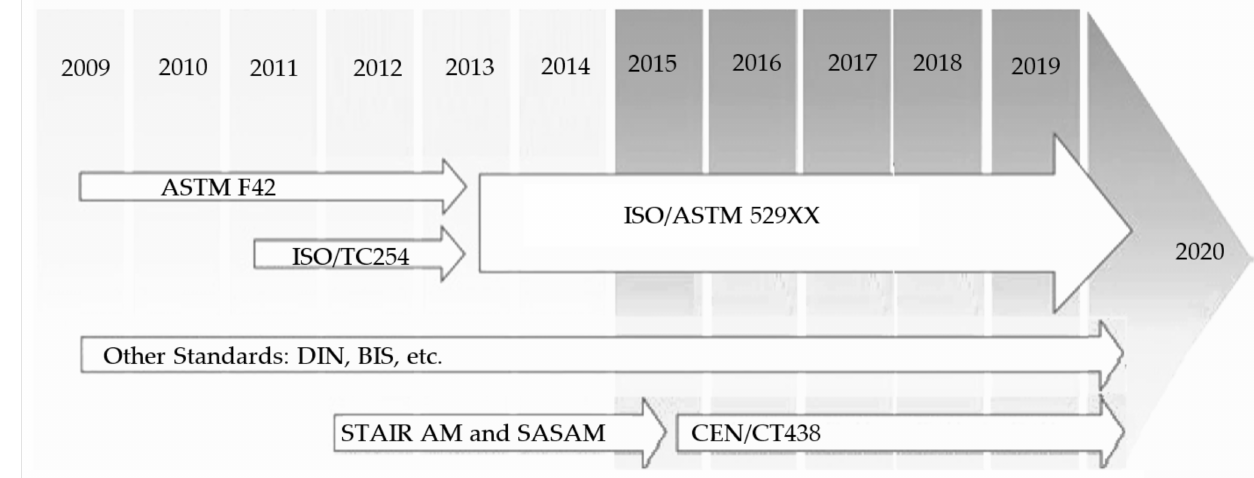
Figure 11. AM standardisation activities.